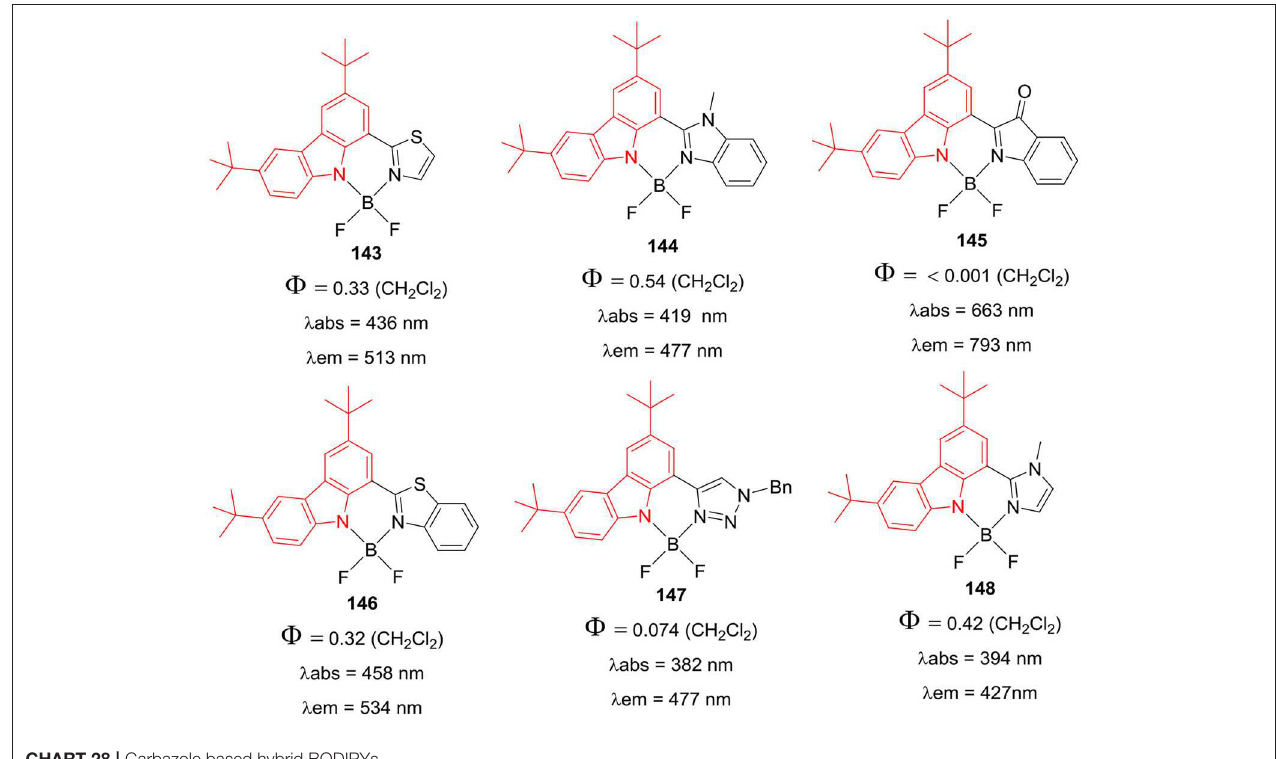
CHART 28 | Carbazole based hybrid BODIPYs.